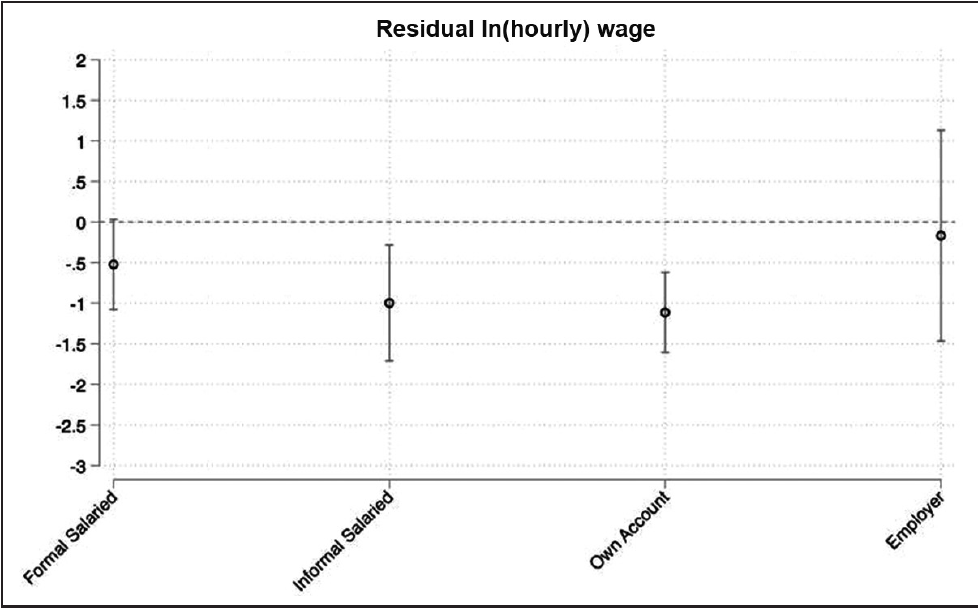
Note : 2SLS, two-stage least squares. They are 95% confidence intervals.